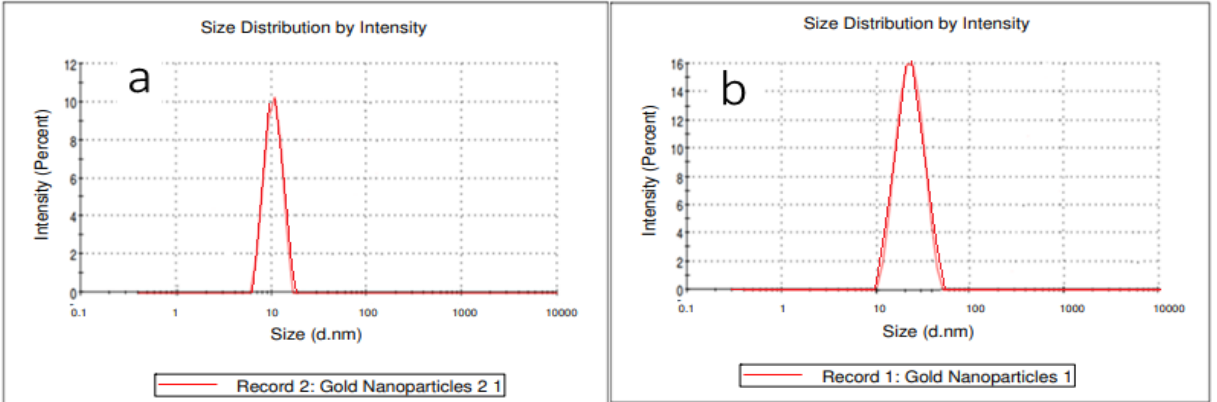
Figure 3. The frequency plot of GNPs prepared under optimal conditions in the presence of the stabilizer PVA. ( a ) using a microreactor, and ( b ) using a batch method (T = 308.15 K, total flowrate of SB and gold with SC = 1.66 × 10 −5 L/s, volumetric ratio of SB/HAuCl 4 = 4:10, pHi = 3, and concentration of HAuCl 4 , SC, and SB = 0.1 mM).